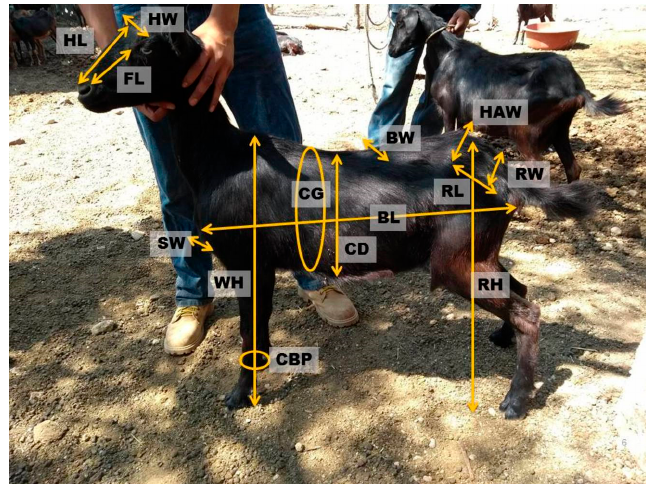
Figure 2. Morphometric variables analyzed: head width (HW), head length (HL), face length (FL), wither height (WH), chest girth (CG), body length (BL), bicostal width (BW), chest depth (CD), shoulder width (SW), rump length (RL), rump width (RW), haunch width (HW), rump height (RH), and cannon bone perimeter (CBP).